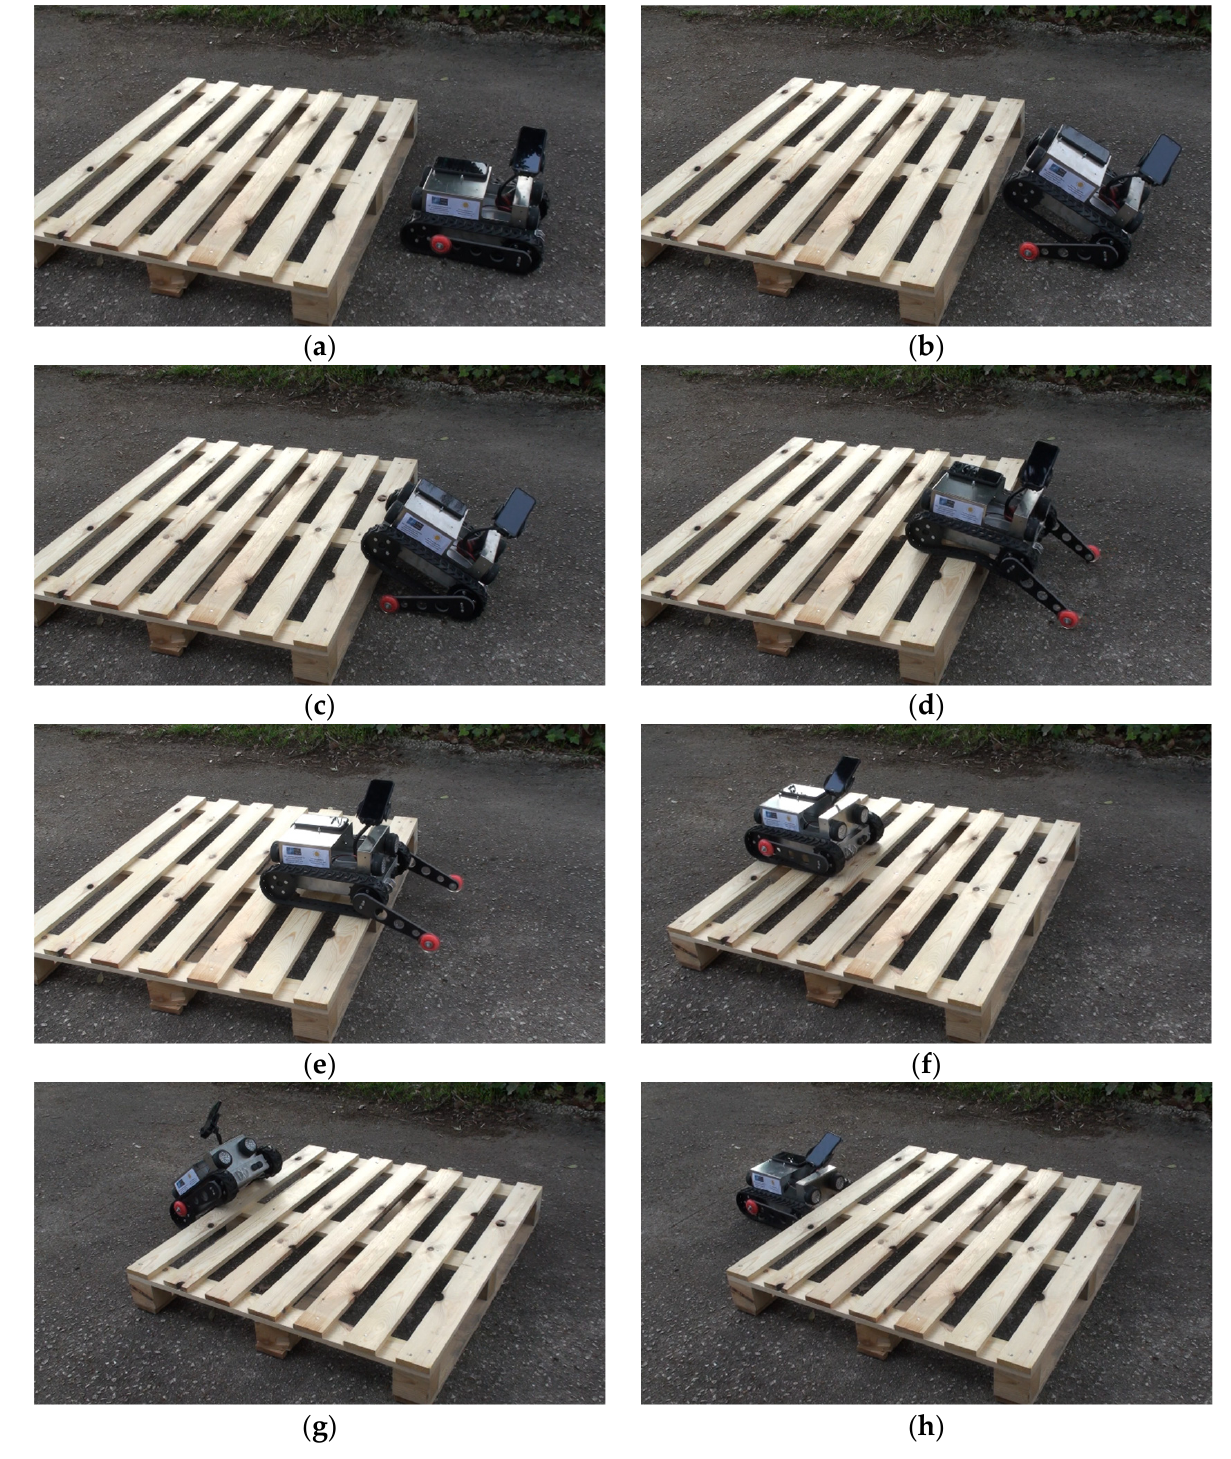
Figure 7. Experimental test simulating the dynamic simulation of the robot in Figure 6: ( a ) approach; ( b ) legs rotate cw; ( c ) robot moves forward; ( d ) legs rotate ccw; ( e ) robot advances; ( f ) robot negotiates with the five slopes; ( g ) robot moves forward and descends; ( h ) robot descends completely.